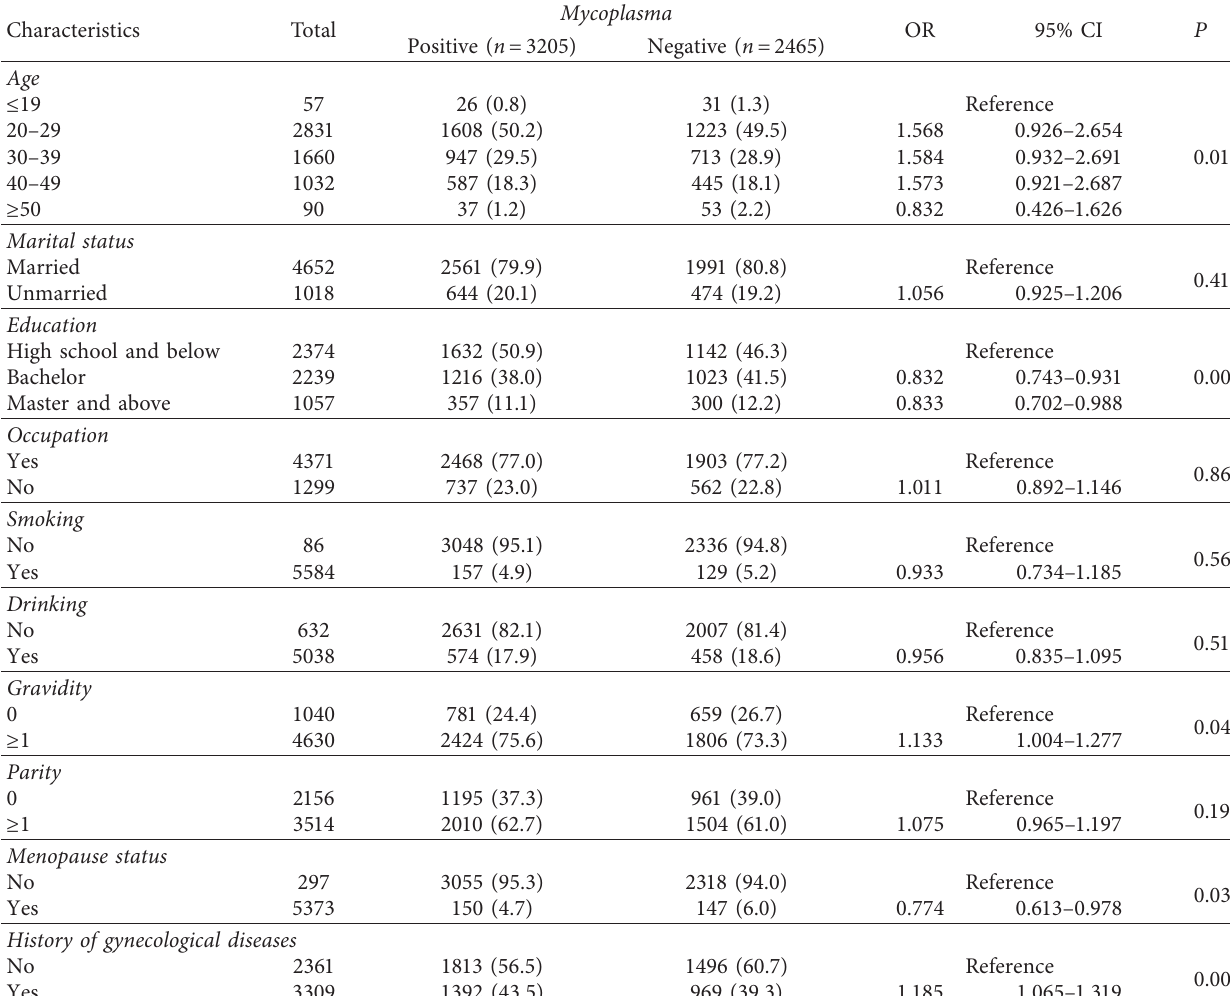
Table 1: Clinical characteristics of gynecological